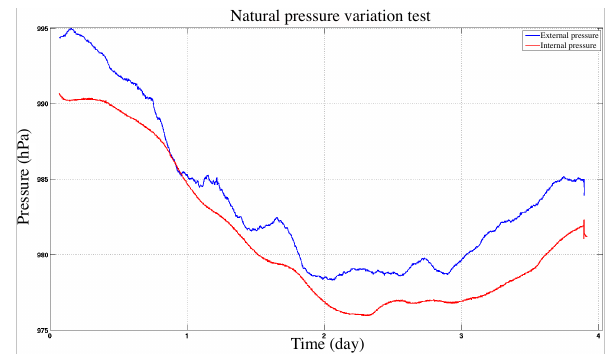
Fig. 5. Effect of a rapid pressure change applied outside the TANK protection.